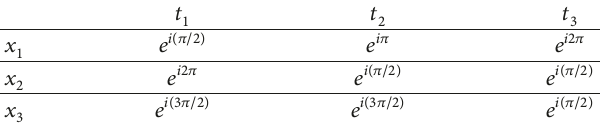
Table 2: 𝛼 A (𝑥,𝑡) = 𝛽 A (𝑥,𝑡) .